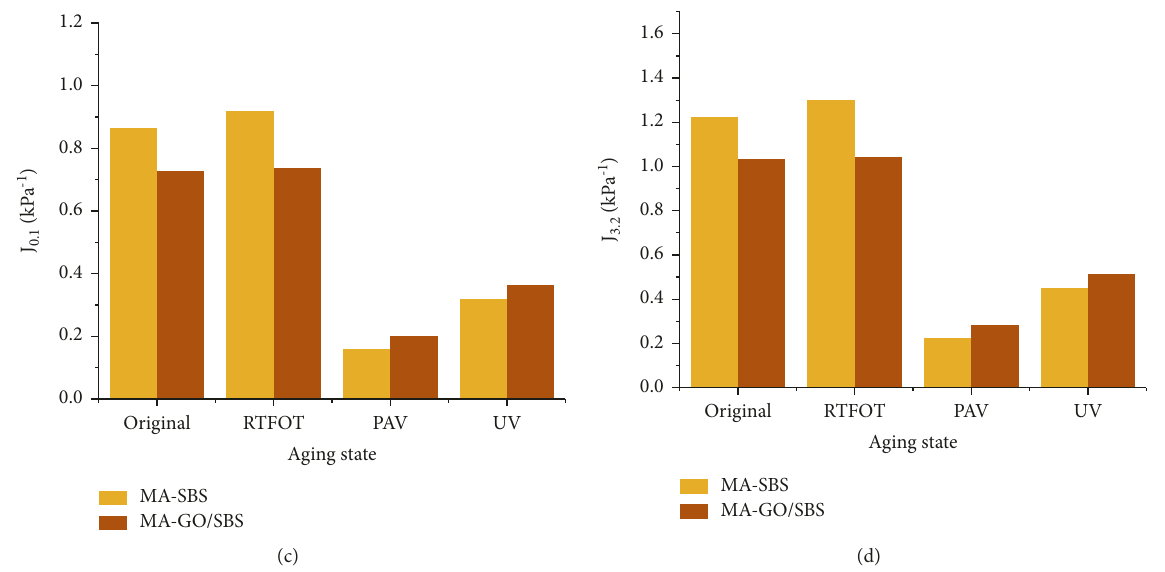
Figure 10: The R 0.1 (a), R 3.2 (b), J nr0.1 (c), and J nr3.2 (d) values of the SBS- and GO/SBS-modified asphalt